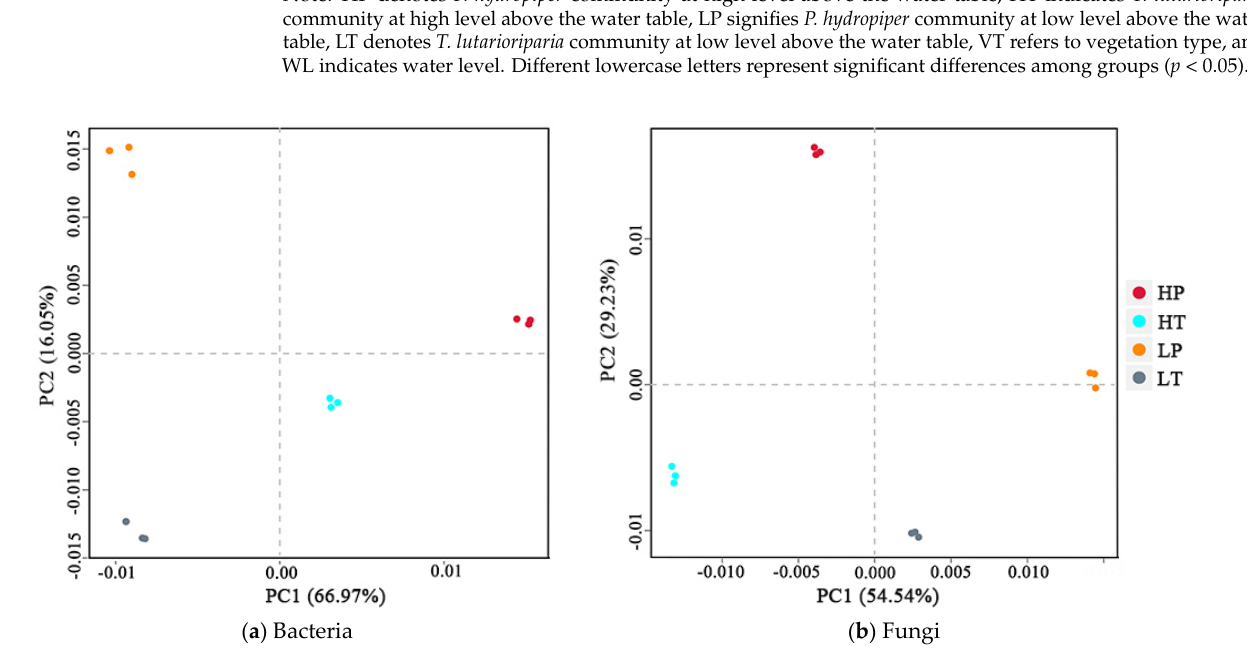
Figure 2. Principal component analysis (PCA) of soil microbial communities in different groups. HP denotes P. hydropiper community at high level above the water table, HT signifies T. lutarioriparia community at high level above the water table, LP indicates P. hydropiper community at low level above the water table, and LT refers to T. lutarioriparia community at low level above the water table.